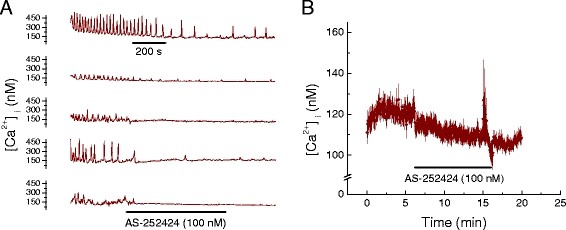
Pharmacologic inhibition of phosphoinositide-3-kinase (PI3K) isoform γ decreases Ca
2+
, [Ca
2+
]
i
, in HL-1 cell mouse cardiomyocytes.
A
. Effect of AS-252424 (100 nM) on [Ca2+]i oscillations in five representative HL-1 cells. Time base applies to all traces.
B
. Effect of AS-252424 (100 nM) on average [Ca2+]i in cells displaying oscillating and non-oscillating [Ca2+]i (mean ± SEM; n = 5, each an average of 25 to 40 cells as shown in A.